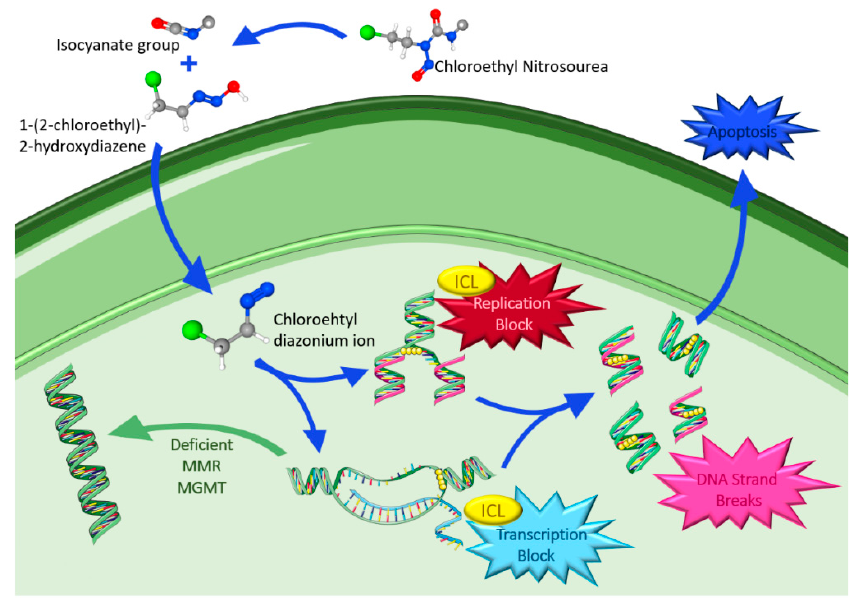
Figure 4. Chloroethyl nitrosoureas metabolism, mechanism of action and drug resistance. Atom color codes: blue, nitrogen; grey, carbon; red, oxygen; white, hydrogen; green, chlorine; grey + white, radical. Figure drawn with smart.servier.com and using molecules from PubChem [78–80]. ICLs are cytotoxic DNA lesions that link the DNA strands covalently and block DNA replication and transcription, resulting in cellular damage and apoptosis. On the other hand, isocyanate does not appear to be directly involved in the antitumor effects of CNU; instead, it inhibits DNA polymerase and other enzymes involved in the repair of DNA